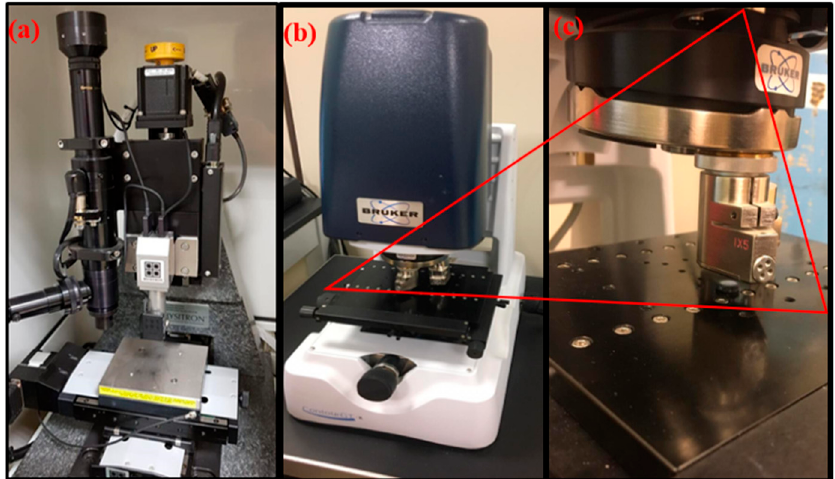
Figure 2. ( a ) Hysitron Nano-mechanical testing instrument, ( b ) optical microscope (Bruker ® ), 3D non- contact surface profilometer, ( c ) magnified image of mounted sample on stage.